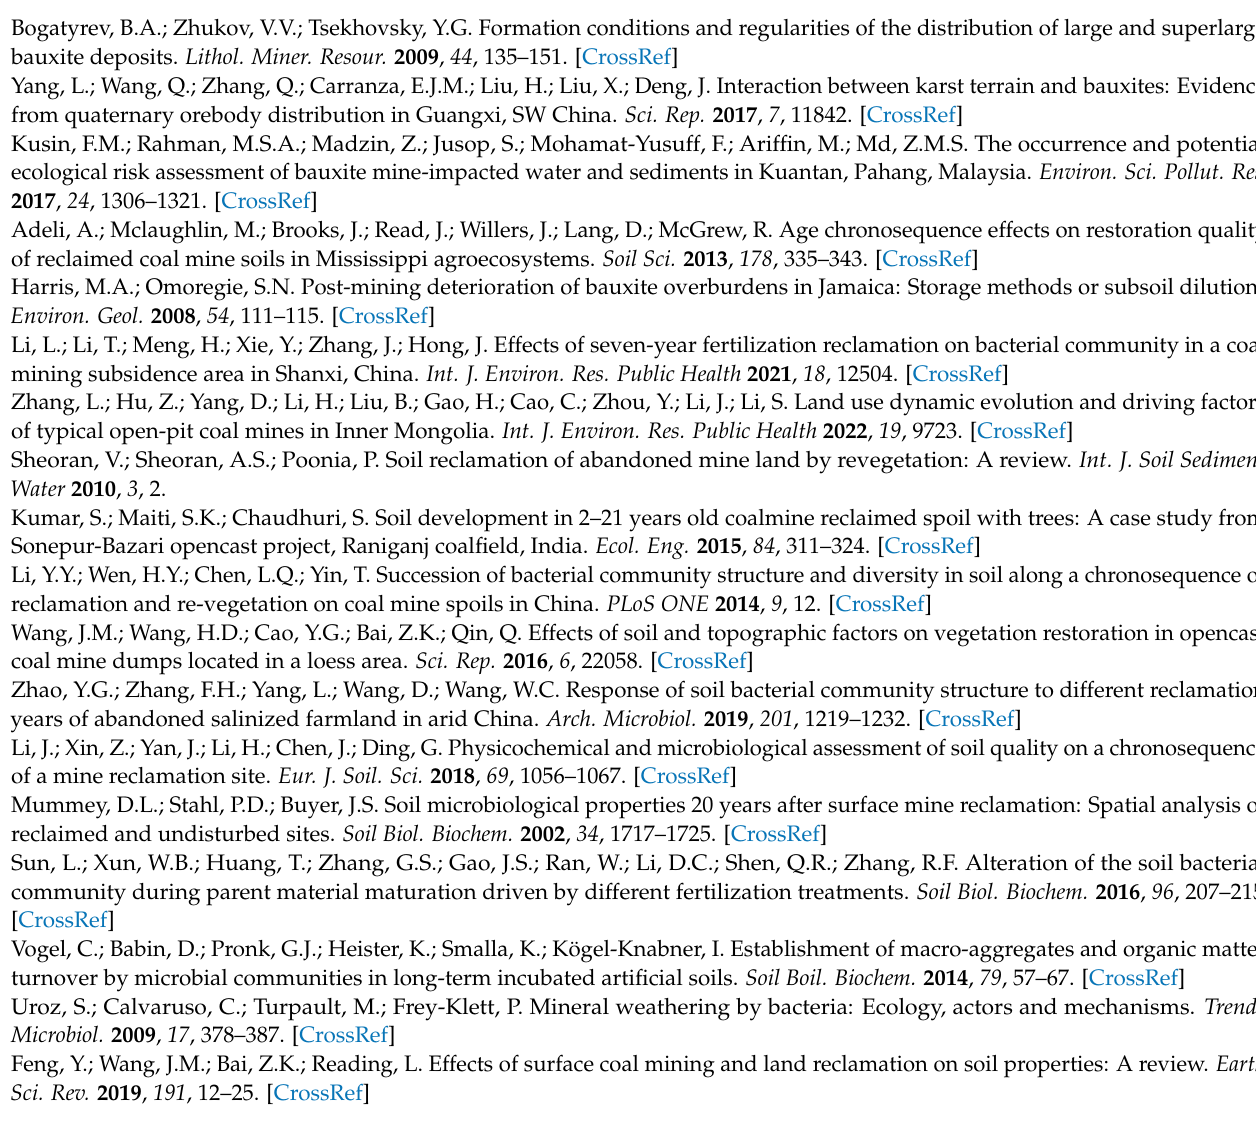
Classification Standard of China, Figure S1: Bacterial community composition at the level of family in different plots, Figure S2: Correlations of dominant family and soil physicochemical